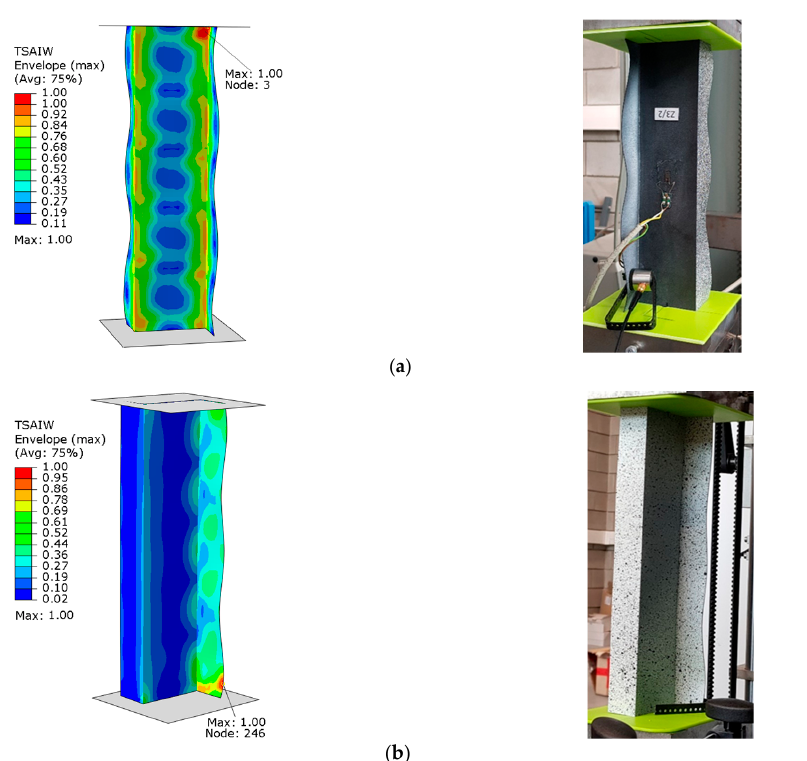
Figure 11. Column z_1—maps of the Tsai–Wu critical parameter and forms of post-critical deformation: ( a ) Test 1 and ( b ) Test 3.